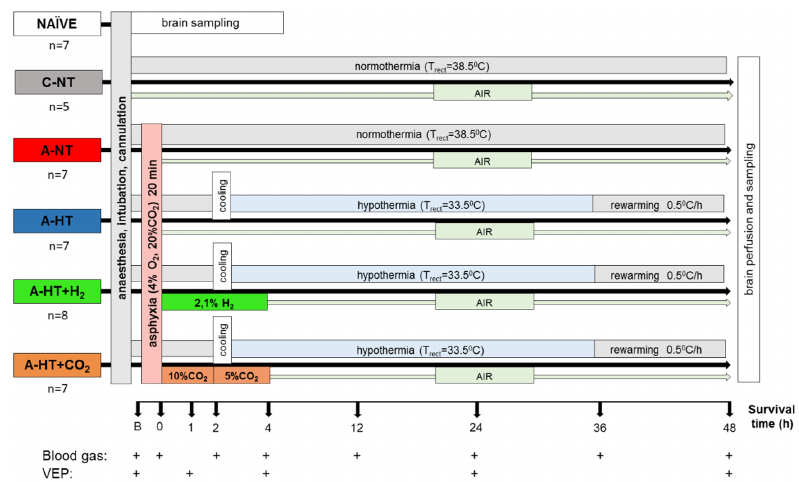
Figure 1. Overview of the experimental protocol. Untreated animals served as naïve controls for neuropathology and gene expression studies; piglets in the control-normothermia group (C-NT) were anesthetized, ventilated, and monitored but not subjected to asphyxia. Animals of the asphyxia-normothermia group (A-NT) were exposed to 20 min asphyxia induced by ventilation with 4% O 2 –20% CO 2 gas mixture. Animals in the asphyxia-hypothermia group (A-HT) were cooled down to 33.5 °C, starting 2 h after reventilation, and were gradually rewarmed from 36 h to normothermia by 0.5 °C/h in 10 h. H 2 -treatment was initiated at the onset of reventilation after asphyxia (21%O 2 – 2.1% H 2 , 4 h) and was combined with hypothermia (A-HT + H 2 group). In a similar fashion, CO 2 - treatment was initiated at the onset of reventilation after asphyxia and was combined with hypothermia (A-HT + CO 2 group). In order to achieve graded restoration of normocapnia, the animals were ventilated first with 21% O 2 –10% CO 2 for 2 h and then with 21% O 2 –5% CO 2 for 2 h before switching back to air. Arterial blood samples were collected and visual evoked potential (VEP) measurements were performed at the marked time points.